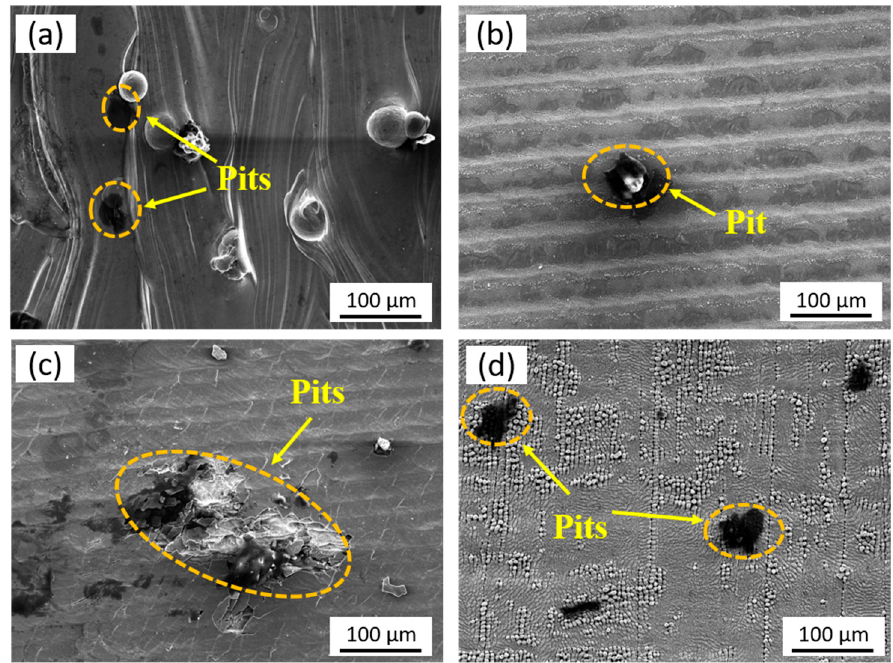
Figure 11. Surface corrosion morphologies of the ( a ) original, ( b ) CW, ( c ) NS, and ( d ) FS laser-pol- ished 316L stainless steel samples. 316L stainless steel